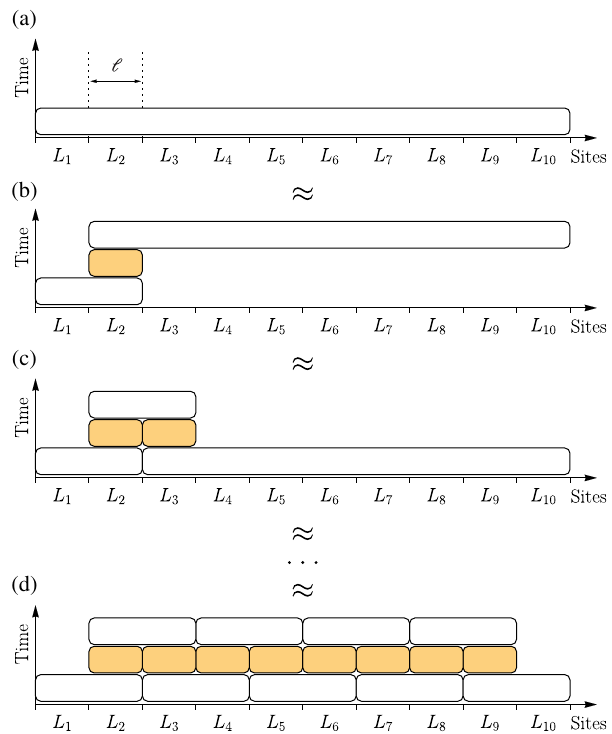
FIG. 4. A demonstration of the HHKL decomposition [27] of the evolution of a fixed time interval for a system with m ¼ 10 blocks, each consisting of l sites. As before, each box represents a unitary (white) or its Hermitian conjugate (orange) supported on the covered sites. Using Lemma 1, the HHKL decomposition approximates the evolution of the whole system (a) by three unitaries supported on subsystems (b). By applying Lemma 1 repeatedly [(c),(d)], the evolution of the whole system is decomposed into a series of evolutions of subsystems, each of size at most 2 l